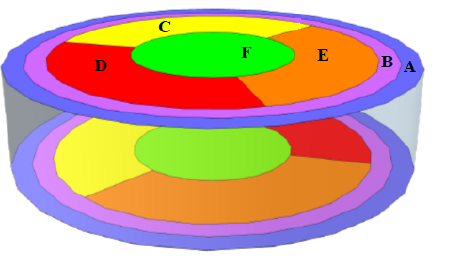
Figure 1. The detector regions of the SuperCDMS detector. To produce interactions at 13 different locations on the detector along a radial path from the center up to the detector’s outer edge, a movable radioactive source was used. The 13 different locations are shown in Figure 2, while the numeric values of the locations are listed in Table